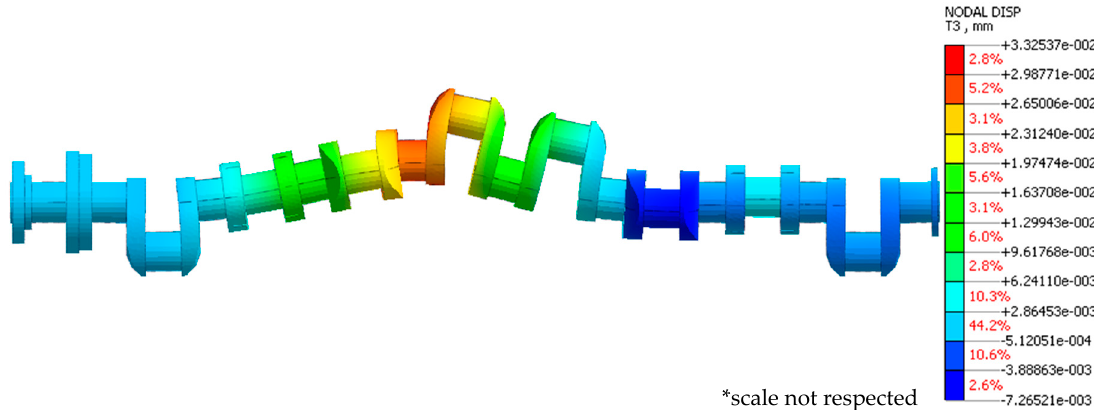
Sensors 2020 , 20 , x FOR PEER REVIEW Figure 6. Exemplary finite element analysis results for case 1. Figure 6. Exemplary finite element analysis results for case 1.